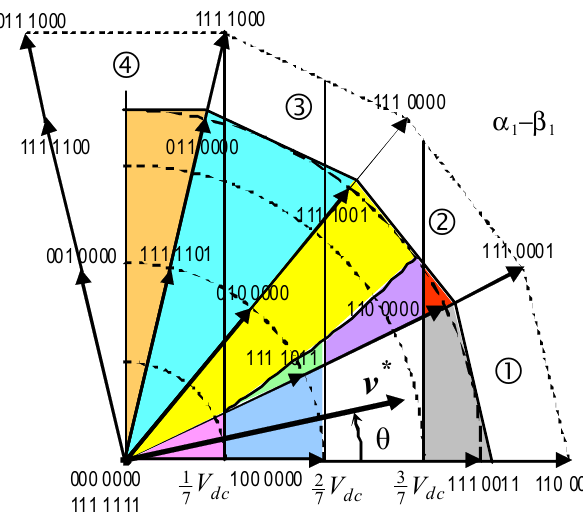
Figure 4. Space vector diagram of inverter output voltage on plane α θ = [0, 90°]. Outer dashed circle is modulation limit, m correspond to different equations for determining the current